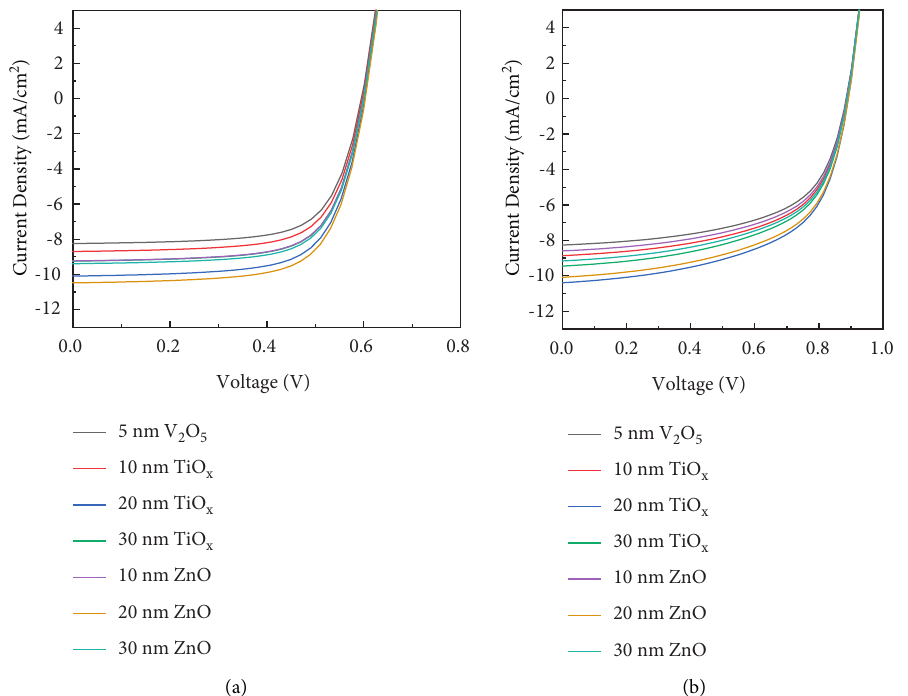
Figure 4: Current density vs. voltage for (a) P3HT:PCBM and (b) PTB7 :PC70BM active layers with different interfaces used as hole and electron transfer layer with various thicknesses.